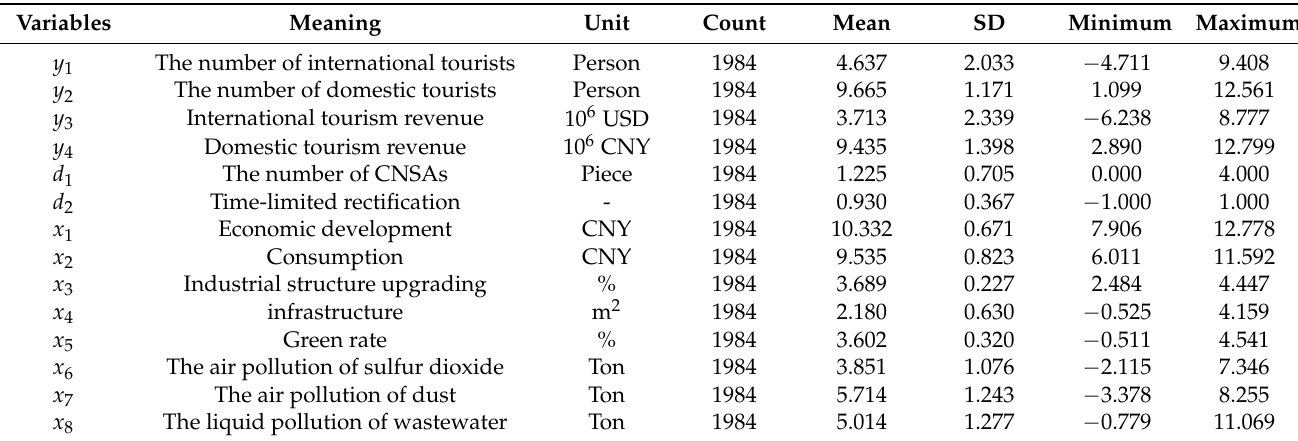
Table 1. The statistical description of relevant